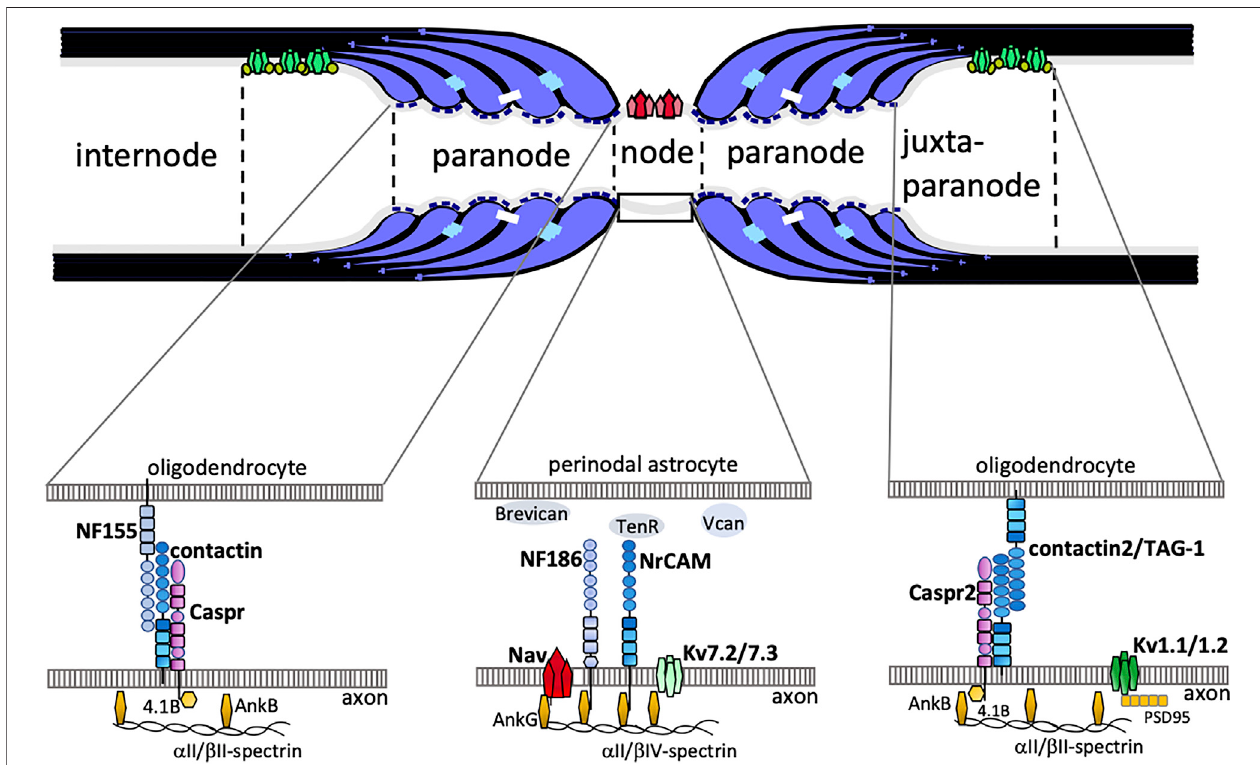
FIGURE 1 | The schematic drawing shows junctional complexes between oligodendrocytes and axons in myelinated axons. The nodal axolemma with voltage- gated Na + channels (Nav) has concentrations of neurofascin 186 (NF186) and neuronal cell adhesion molecule (NrCAM) belonging to the L1-family ofCAMs at the node of Ranvier. The cytoplasmicregion ofaxonal NF186 and NrCAM bindsankyrinG (AnkG), which anchors the nodal complex to β IV-spectrin and tothe actin cytoskeleton. AnkG enables the clustering of Nav and Kv7.2/7.3 channels. Extracellular matrices such as Brevican, Versican (Vcan), and TenascinR (TenR) are surrounding the nodes. At the paranode, the cis-complex of Caspr and contactin interacts in trans with NF155 on the paranodal myelin loop. This complex is stabilized by protein 4.1B which co-localizes with AnkB, aII/bII-spectrin. At the juxtaparanode, Shaker-type voltage gated K+ channels Kv1.1/1.2 form clusters. A complex of contactin2 (also known as TAG-1) and Caspr2 is implicated in the formation of